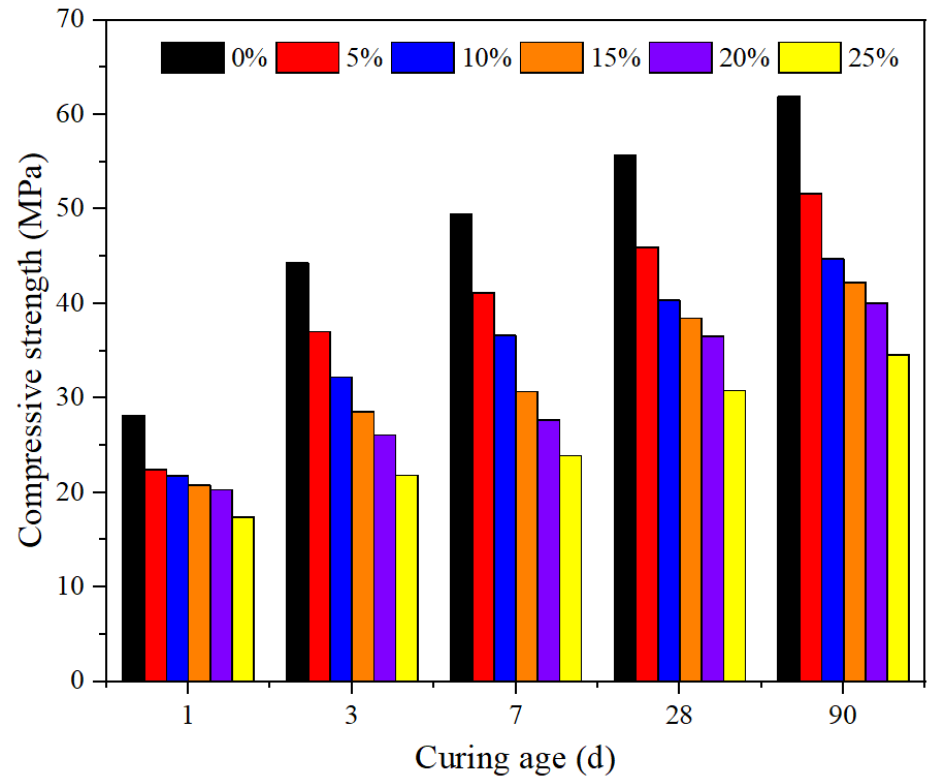
Figure 8. The effect of FBA content on the compressive strength of MPC mortars at different curing ages.